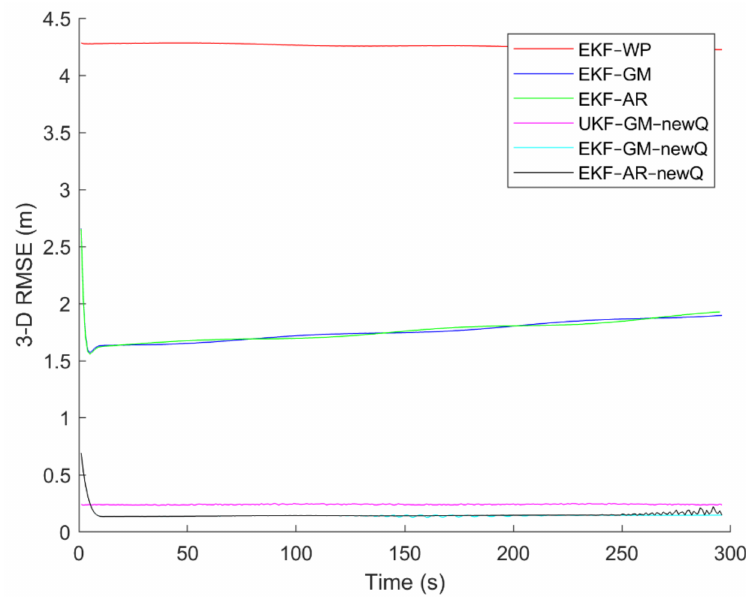
Figure 18. The positioning error of different methods in the third scenario.